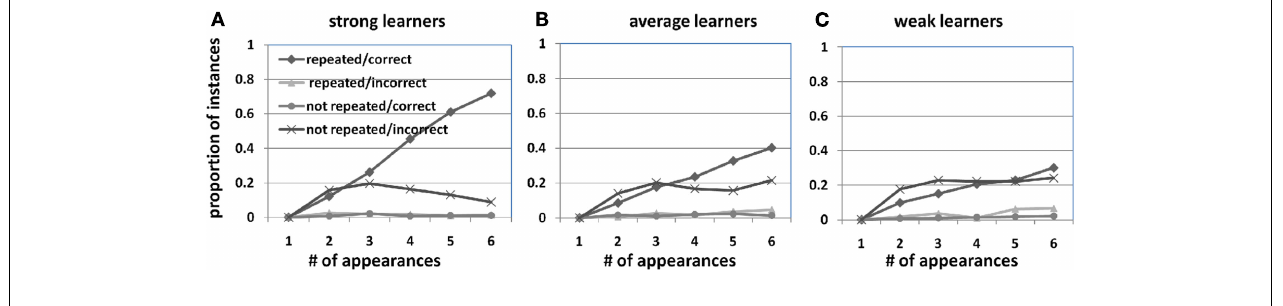
decide to look at a new object instead. Meanwhile, whether repeated or not, the attended object in the current trial may or may not be correct.Taken together, there were four possible gaze patterns across